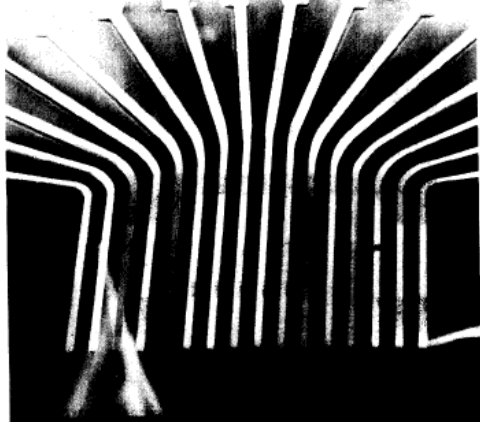
Figure 4. SEM micrograph of the microelectrode array. The Probes are 25 µm wide, 15 µm thick, and 1.15 mm long and have a probe-to-probe spacing of 75 µm. Reprinted from [65]; ©